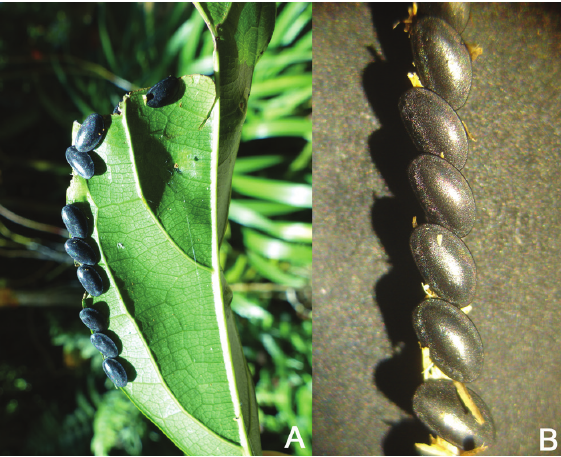
Figure 12. Freshly laid eggs of Gonatoxia maculata ( A ). 26 eggs were laid two days after mating and hatched 7 months later. ( B ) Eggs glued on a twig.